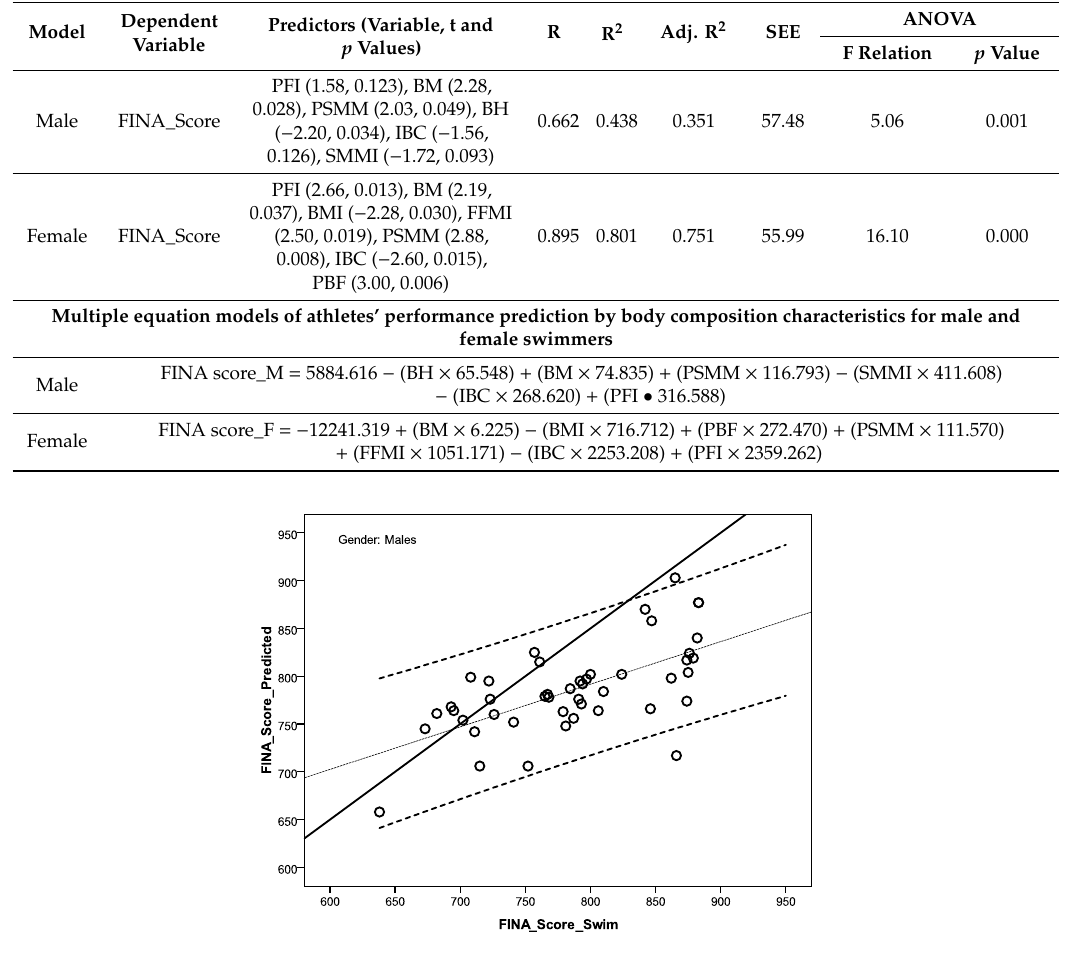
Figure 2. Linear regression for a calculated FINA score and FINA score performance for female sprint swimmers (y = 181.114 × FINA_Score_Swim 0.753 ).